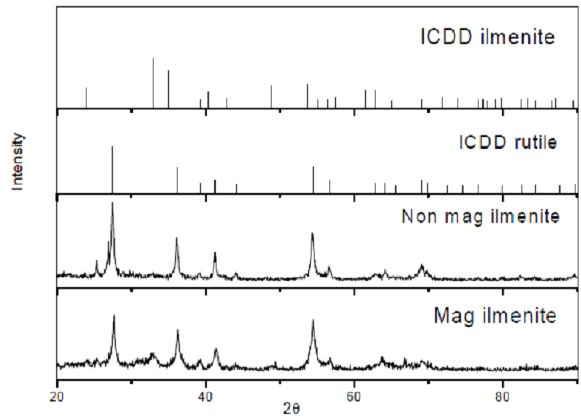
Figure 3: (a) Backscattered images of non magnetic particle of Bomar ilmenite. (a1) EDX of a monazite ((Ce, Nd, La) PO the main ilmenite (FeTiO ) matrix. (b) Backscattered image of magnetic particle of Bomar ilmenite. (b1) EDX of a complex iron aluminum silicate 3 inclusion. (b2) EDX of the main ilmenite (FeTiO ) matrix. 3